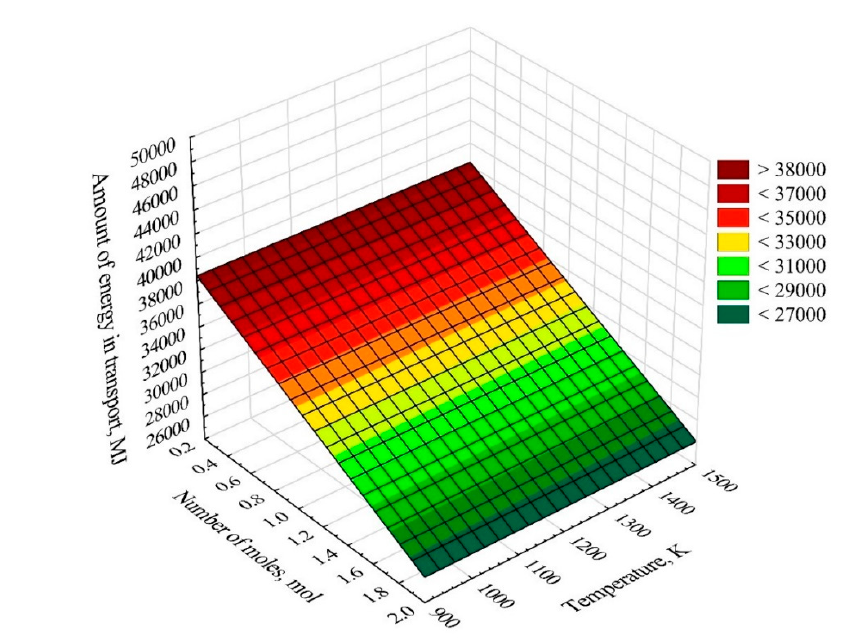
Figure 9. Energy content in the transport of syngas in the pressure vessels with a capacity of 14,960 m 3 at 200 bar at 293 K as a function of the number of moles of the gasification agent (x) and the temperature (y) of the gasification process using CO 2.